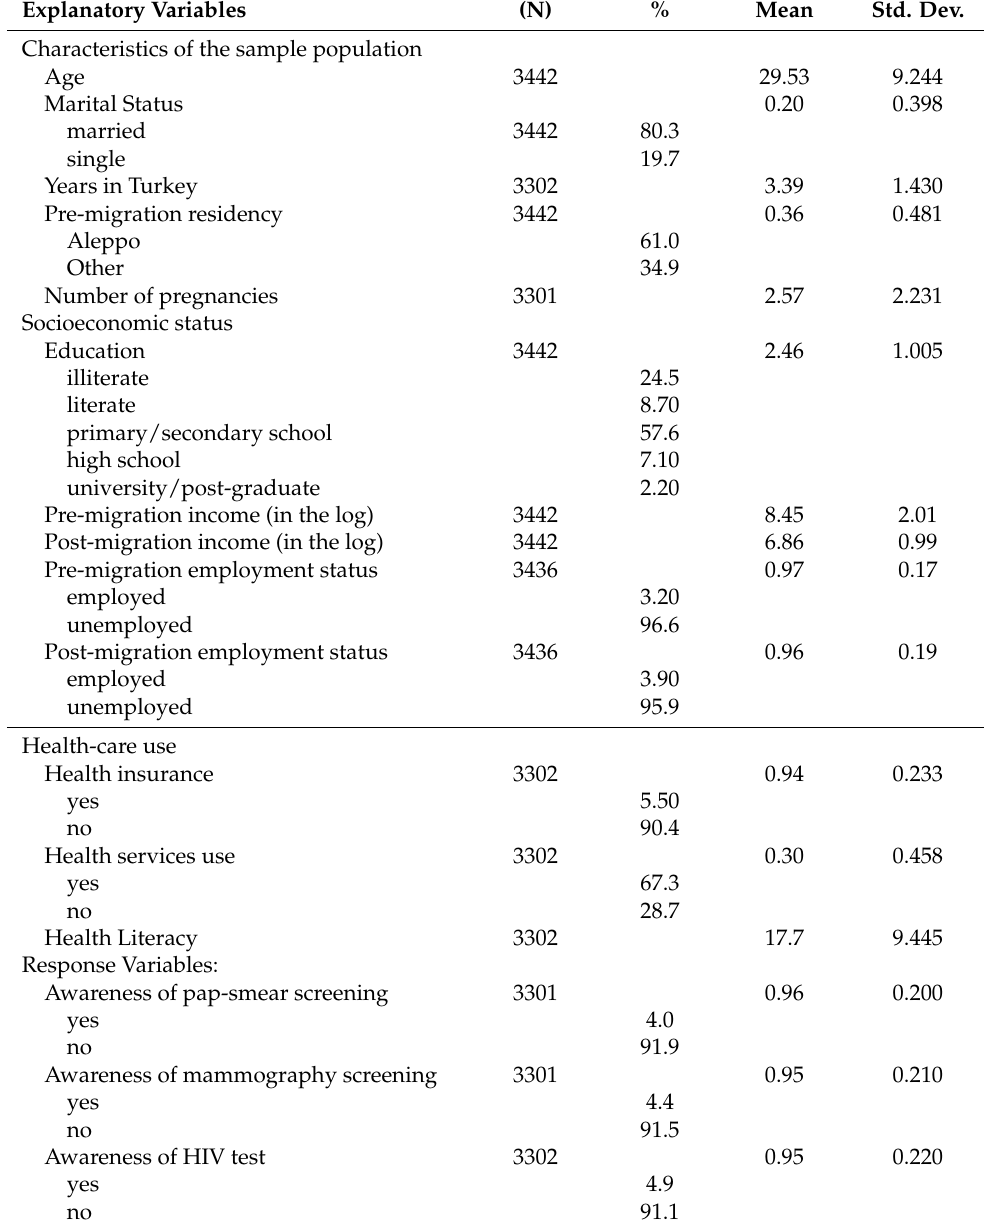
Table 1. Descriptive statistics of the sample